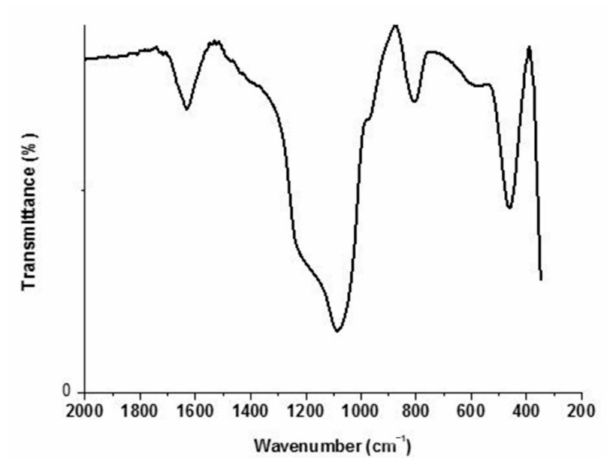
Figure 1. SEM micrographs of the amorphous SiO 2 NPs at different bar scales ( a ) 1 µ m, and ( b ) 0.5 µ m.